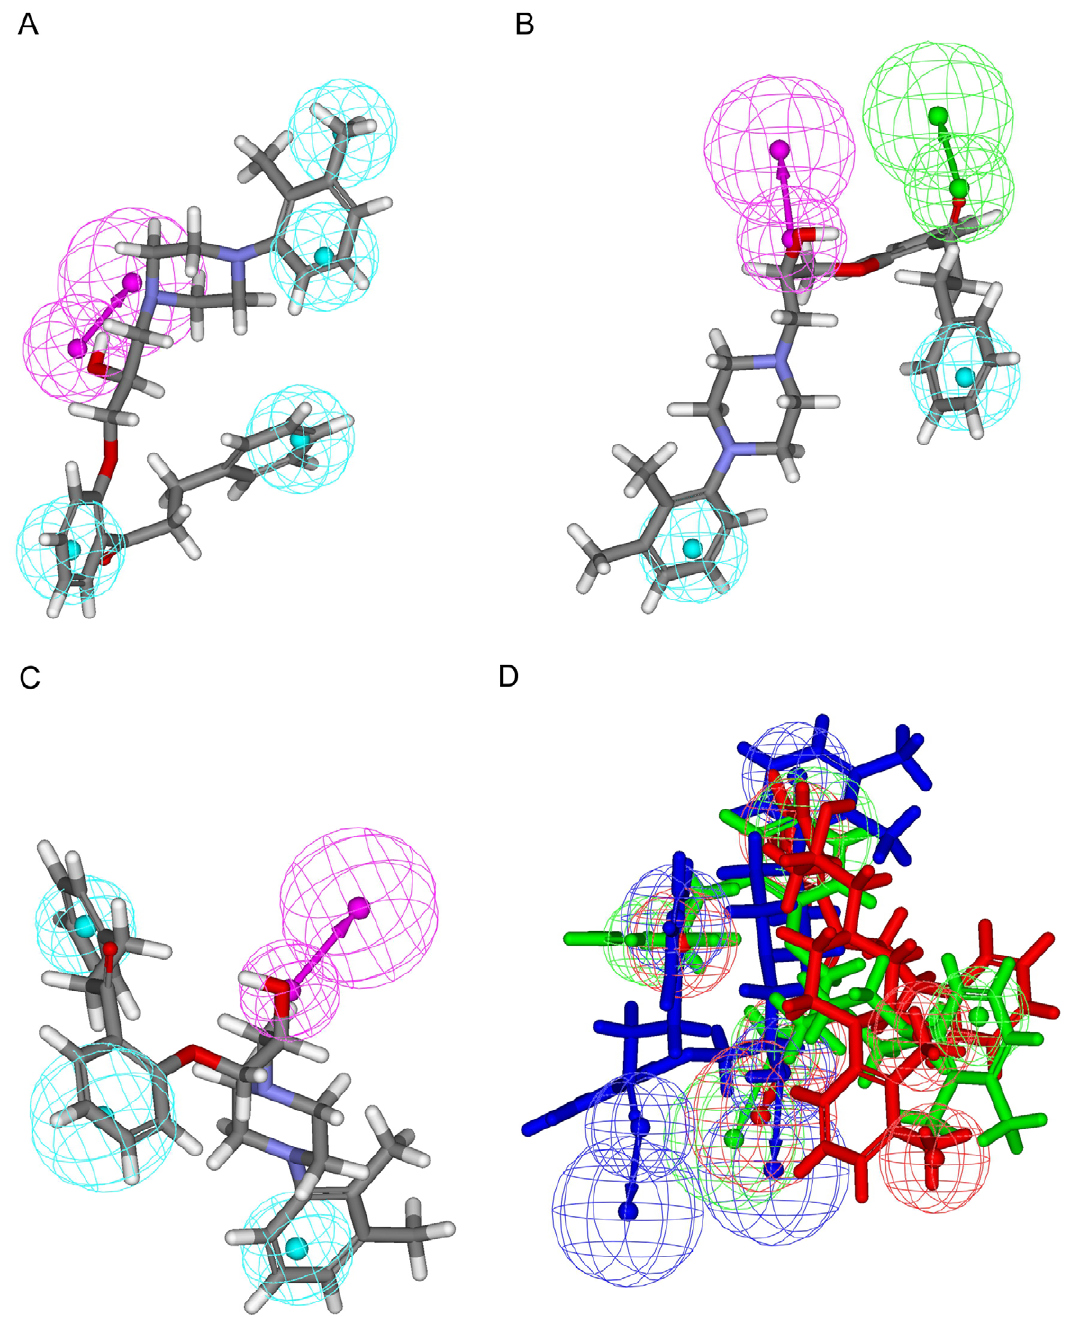
Figure 5. Superposition of pharmacophore models and 89. Pharmacophore models (A) Hypo A, (B) Hypo B and (C) Hypo C fitted to 89 and (E) overlay of these three models, which are color-coded by red, blue and green, respectively. The chemical features are described in Figure